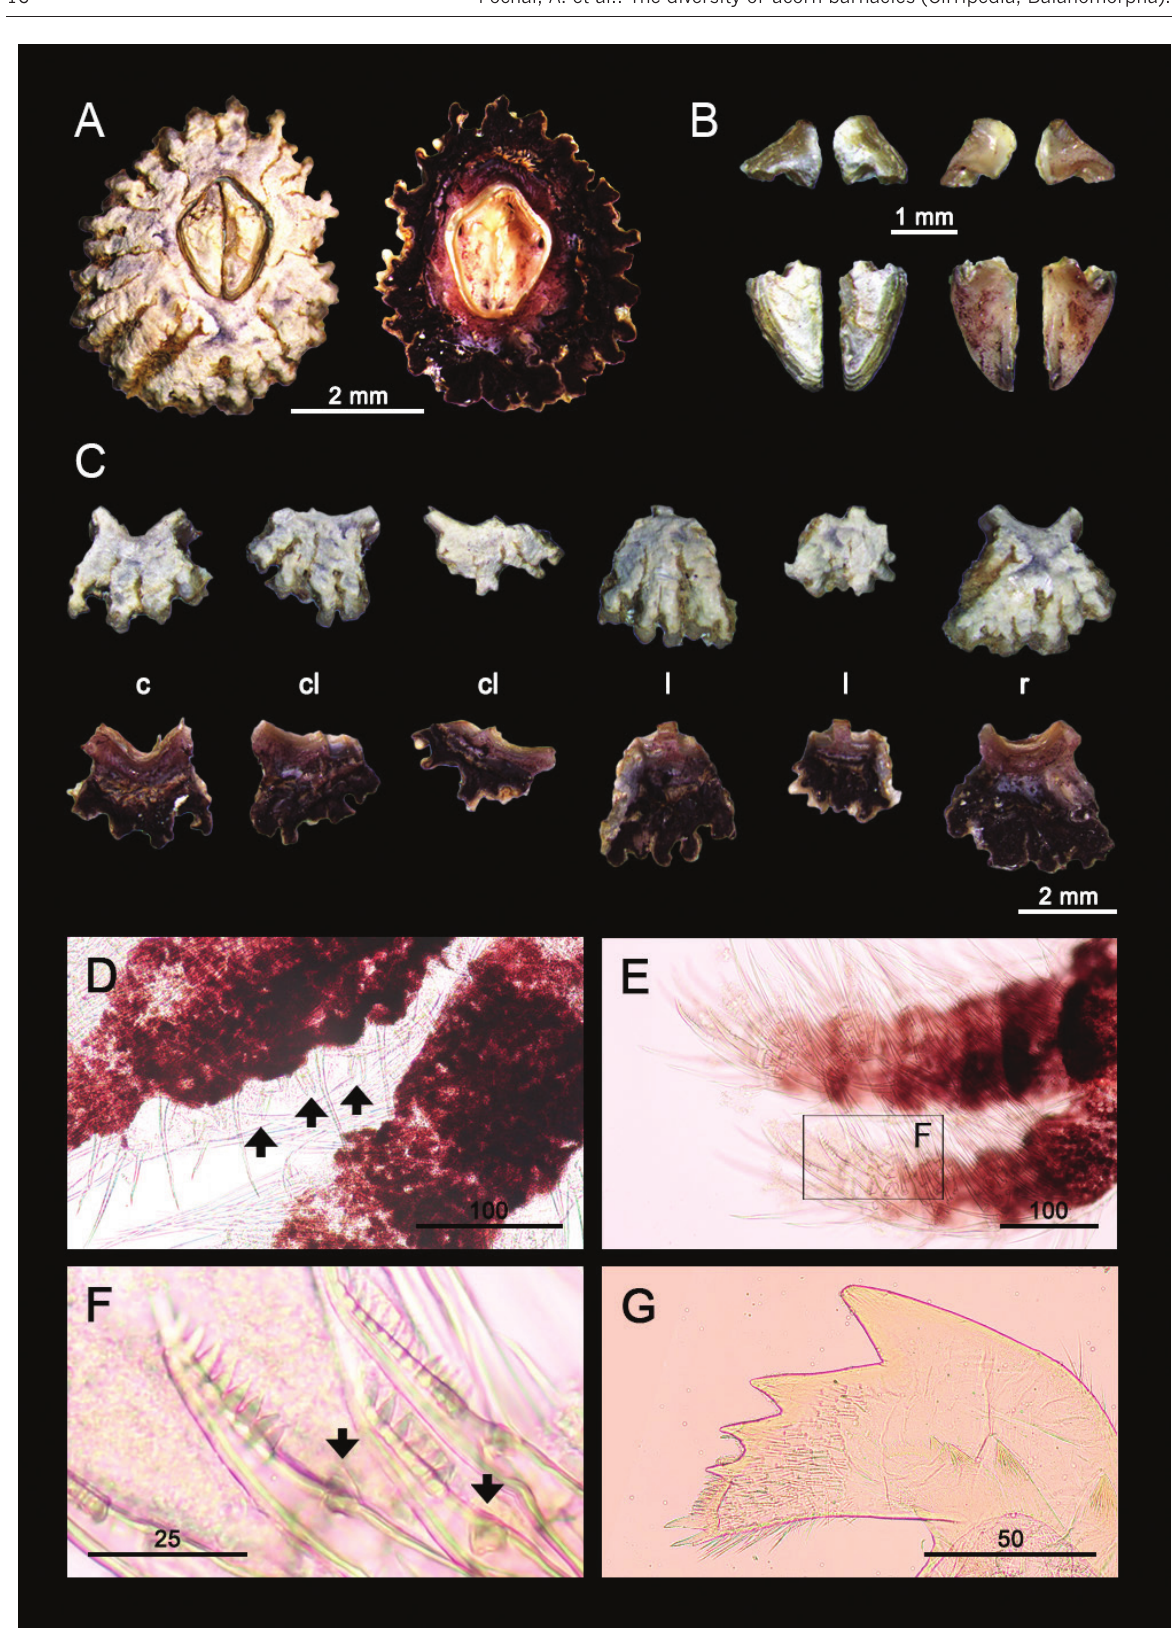
Figure 2. Chthamalus malayensis collected from Ka Lim beach, Phuket (BUU16.CH.CM07). A. Dorsal and ventral view of ex- ternal shell, B. External (left panel) and internal (right panel) view of tergum (upper panel) and scutum (lower panel), C. External (upper panel) and internal (lower panel) view of shell plates, D–G. Light microscopy on mouthparts, D. Close up of cirri I showing conical spines(  ), E. Cirri II, F. Close up on cirri II showing multi-cuspidate setae with basal guard(  ), G. Mandible with four large teeth. D-G. Scale bars in µm. Abbreviations: c, carina; cl, carinal latus; l, latus; r,